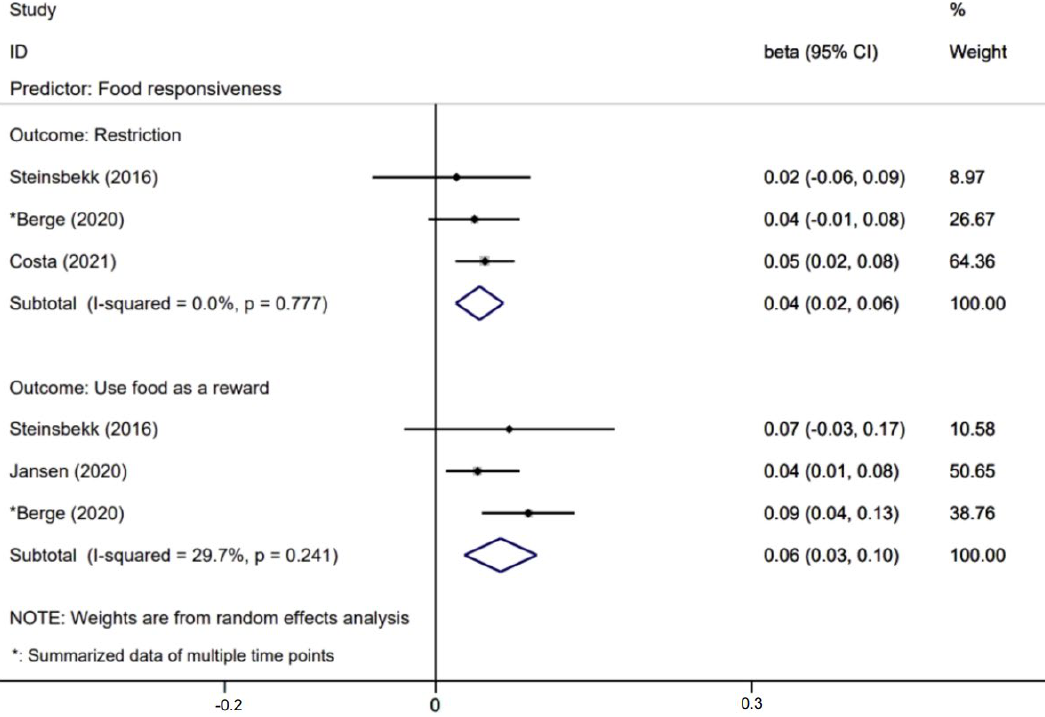
Figure 5. Effects of child food fussiness on parental non-feeding practices.